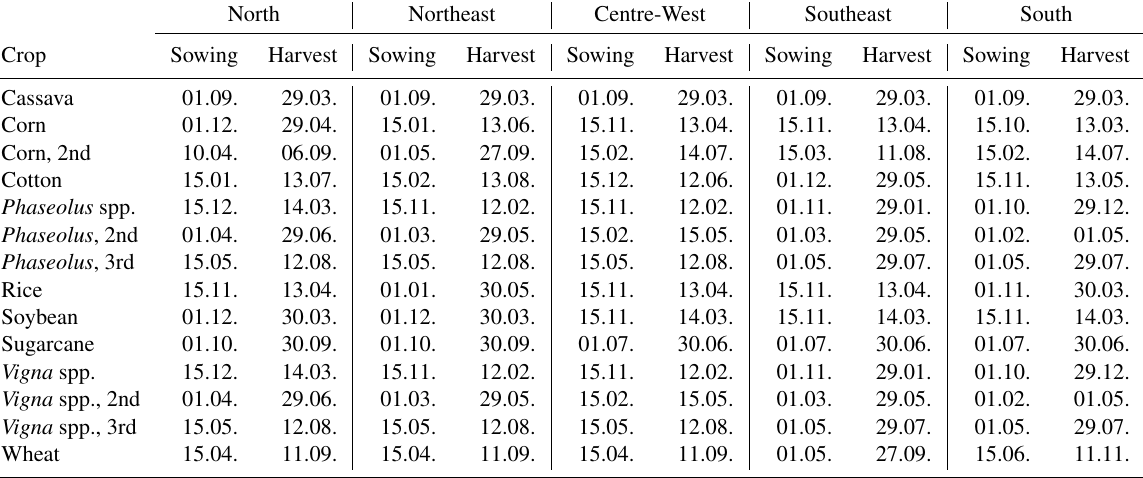
Table A2. Planting and harvesting dates (given in the format dd.mm.) of the different crops and the five sub-regions considered in this study (Conab, 2015). Note that “2nd” and “3rd” are the second and third planting dates for double- and triple-cropping within one growing season, i.e. a successive multiple-cropping practice.